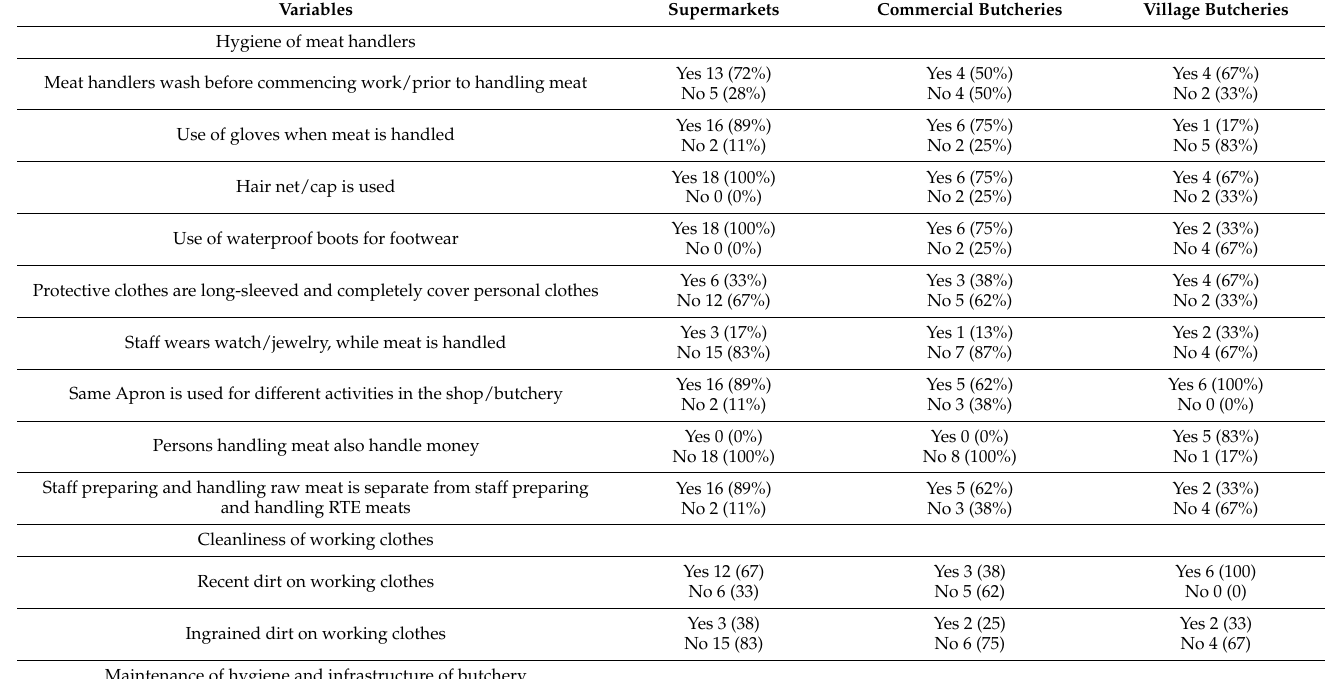
Table 3. Meat safety practices and hygiene at supermarkets and commercial and village butcheries in Vhembe district, Limpopo, South